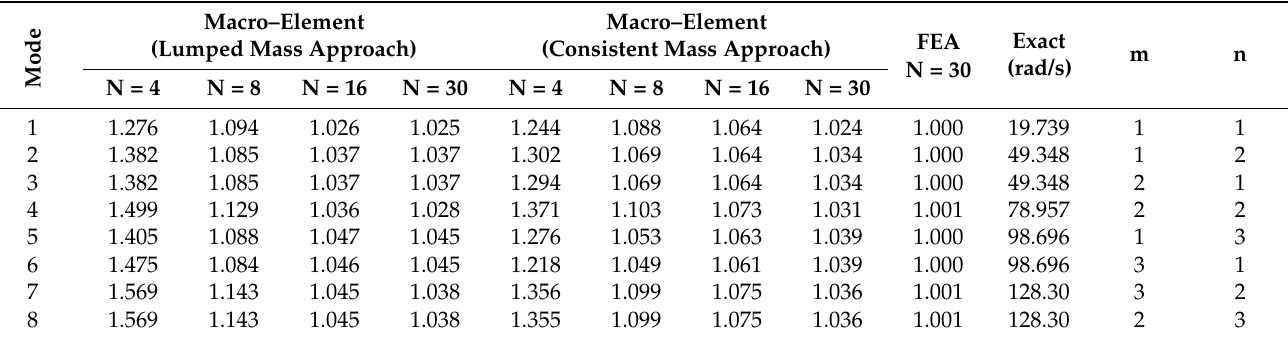
Table 1. Convergence study: normalised natural frequencies ( ω / ω exact ) found for the proposed macro–model and a standard continuous Finite Element Analysis